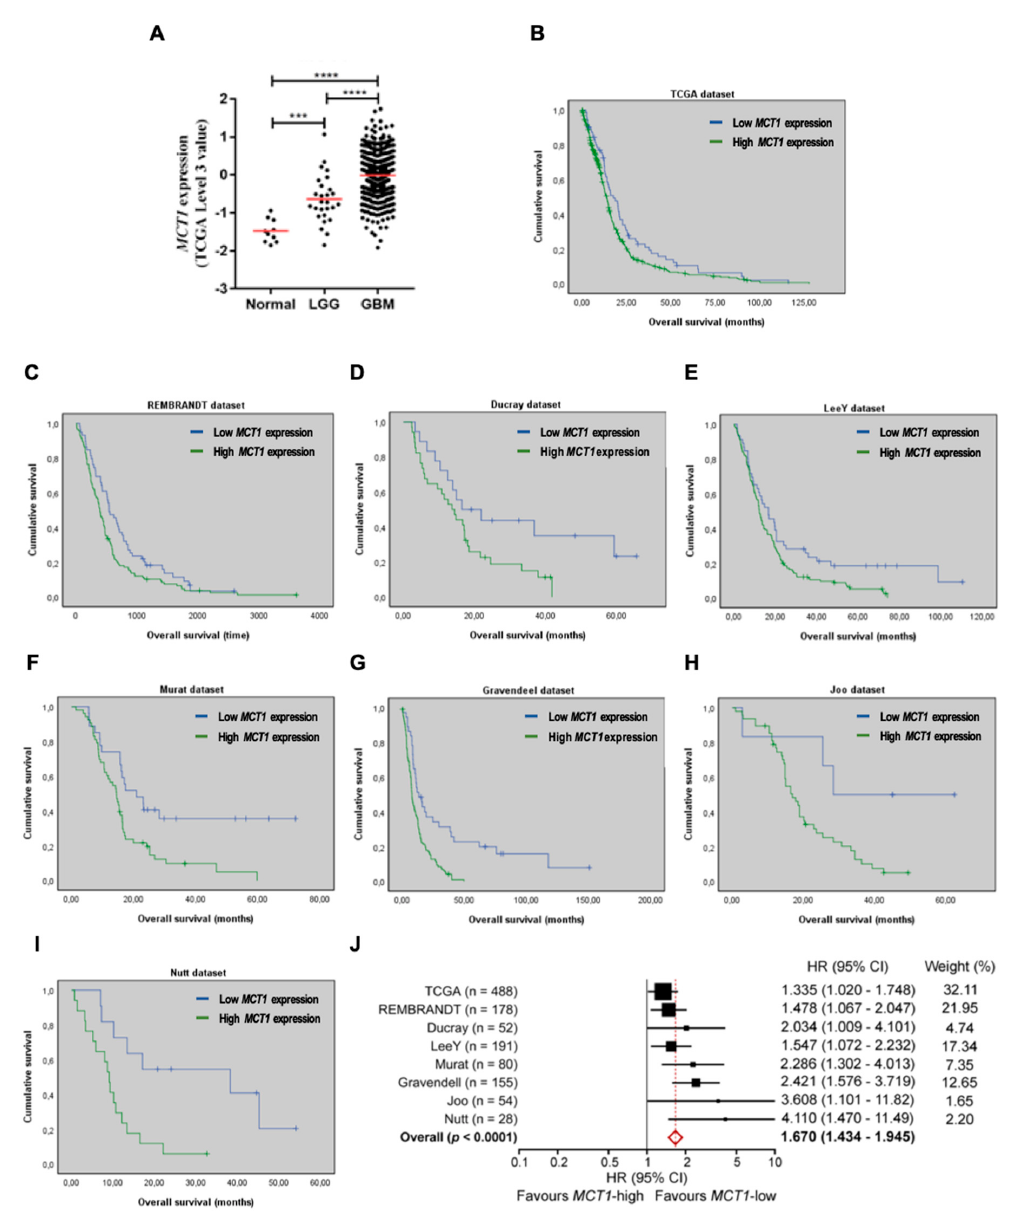
Figure 1. MCT1 is over-expressed in GBM patients and associates with poor prognosis. ( A ) MCT1 expression level in 10 unmatched normal brains, 27 lower-grade gliomas (LGG), and 572 glioblastomas (GBM) patients from TCGA; *** p <0.001 and **** p < 0.0001. ( B – I ) Kaplan-Meier survival curves of MCT1 -low and MCT1 -high GBM patients derived from microarray data from ( B ) TCGA dataset, n = 488, median OS 17.6 vs. 13.9 months, low vs. high MCT1 expression, respectively; p = 0.034; (C) REMBRANDT dataset, n = 178, median OS 541 vs. 390 days ( p = 0.018); ( D ) Ducray dataset, n = 52, median OS 16.5 vs. 13.7 months ( p = 0.043); ( E ) Lee Y dataset, n = 191, median OS 16.6 vs. 12.2 months ( p = 0.018); ( F ) Murat dataset, n = 80, median OS 20.9 vs. 14.4 months ( p = 0.003); ( G ) Gravendeel dataset, n = 155, median OS 13.3 vs. 7.8 months ( p = 0.000031); ( H ) Joo dataset, n = 54, median OS 28.4 vs. 16.9 months ( p = 0.022); ( I ) Nutt dataset, n = 28, median OS 38.2 vs. 9.1 months ( p = 0.004); and ( J ) Forest plot of hazard ratios (HR), demonstrating the relationship between MCT1 expression and GBM patients’ overall survival. The HR for each cohort is represented by a black square (its size represents the weight of the study for the meta-analysis) and 95% confidence intervals (CI) by the extending lines. The estimated pooled effect is represented by a red diamond (HR = 1.670; 95% CI, 1.434–1.945; p < 0.0001).